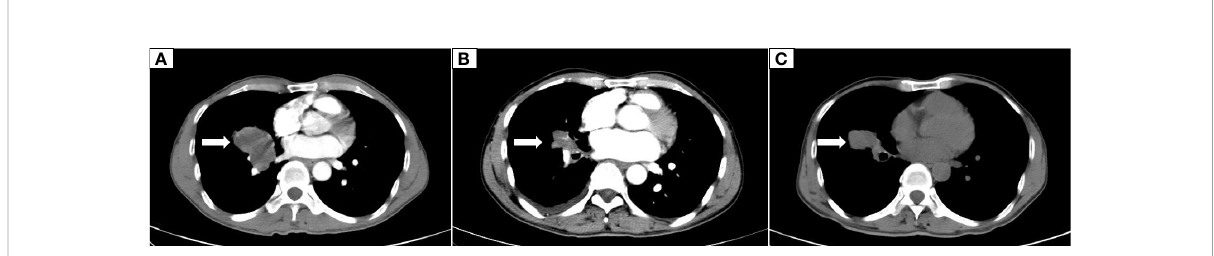
FIGURE 1 Dynamic changes on chest CT. (A) The initial CT scan on January 23, 2019, showed an irregular soft tissue mass measuring 5.7 cm × 4.5 cm in the middle and lower lobes of the right lung. (B) A CT scan on December 9, 2019, showed that the right lung lesion was reduced to 2.5 cm ×